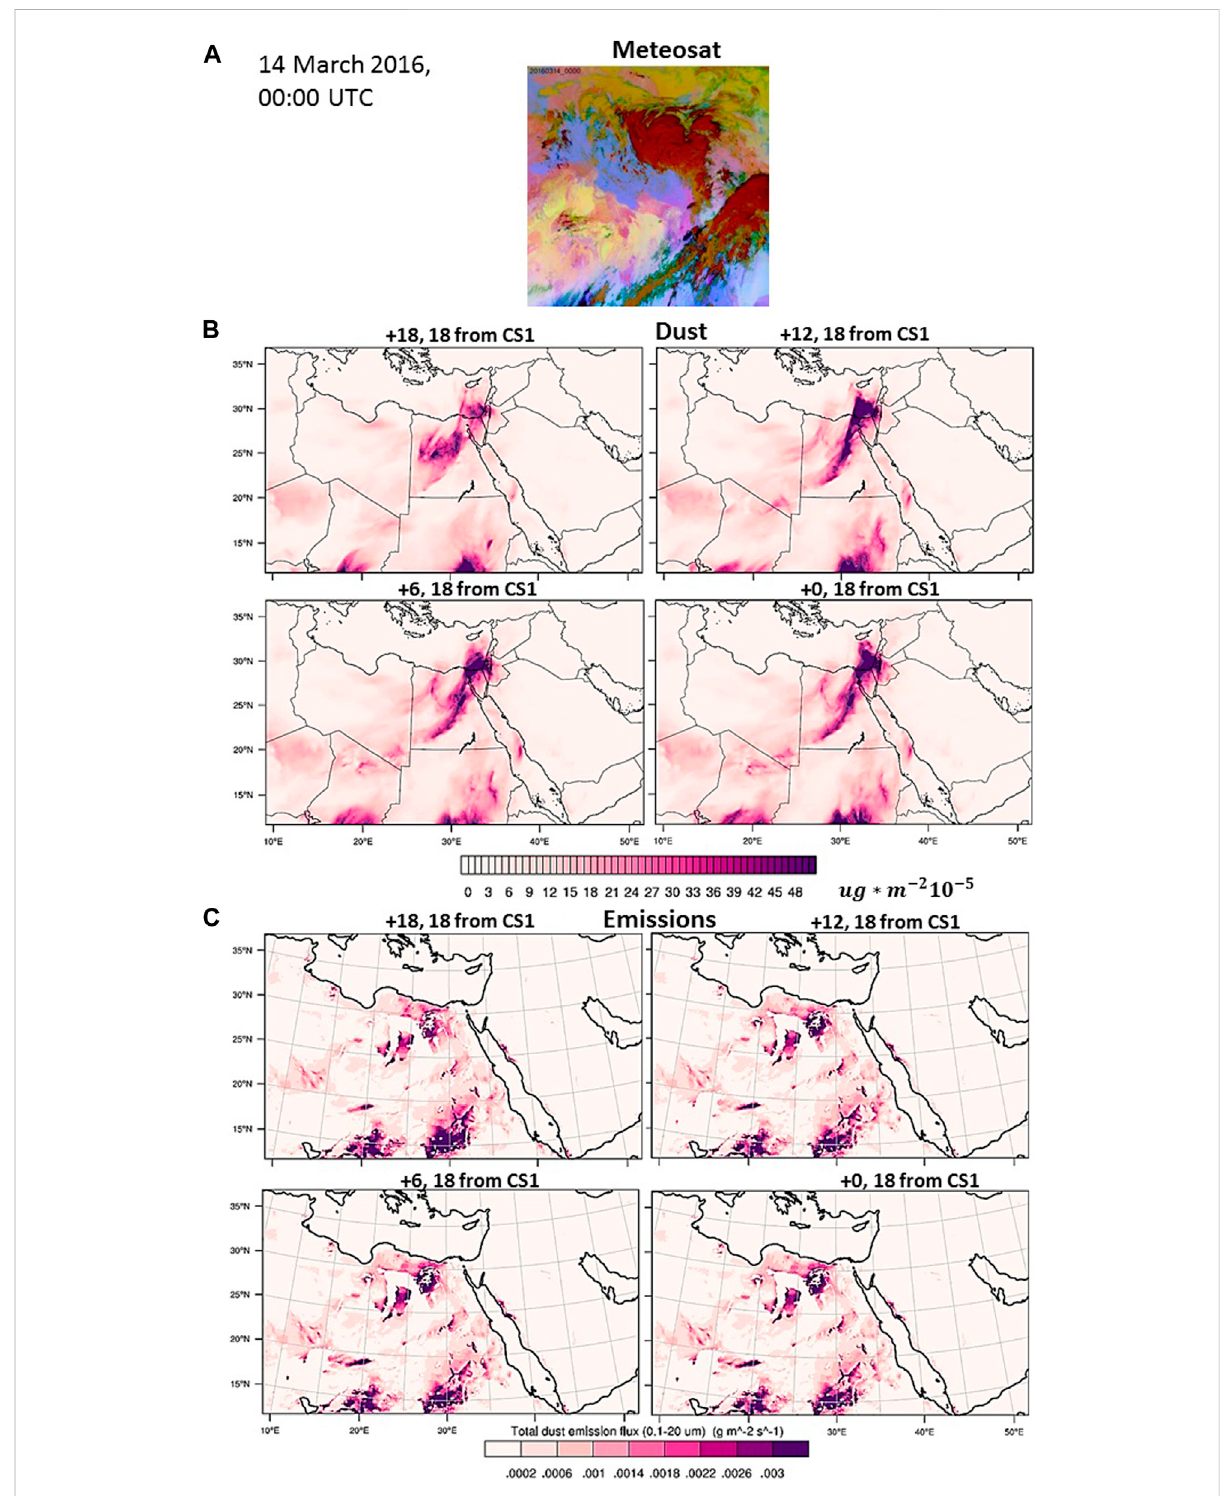
FIGURE 3 ComparisonofthemodeledtotaldustandemitteddustconcentrationsagainsttheMeteosatmeasurementsvalidat00UTC14March2016: (A) Meteosat image, (B) total dust ( ug * m − 2 10 – 5 ), (C) emitted dust ( gm − 2 s − 1 ). The valid time, forecast lead time and time distance from the CS (CS1 or CS2 representing the fi rst or the second CS) are shown at the top of each